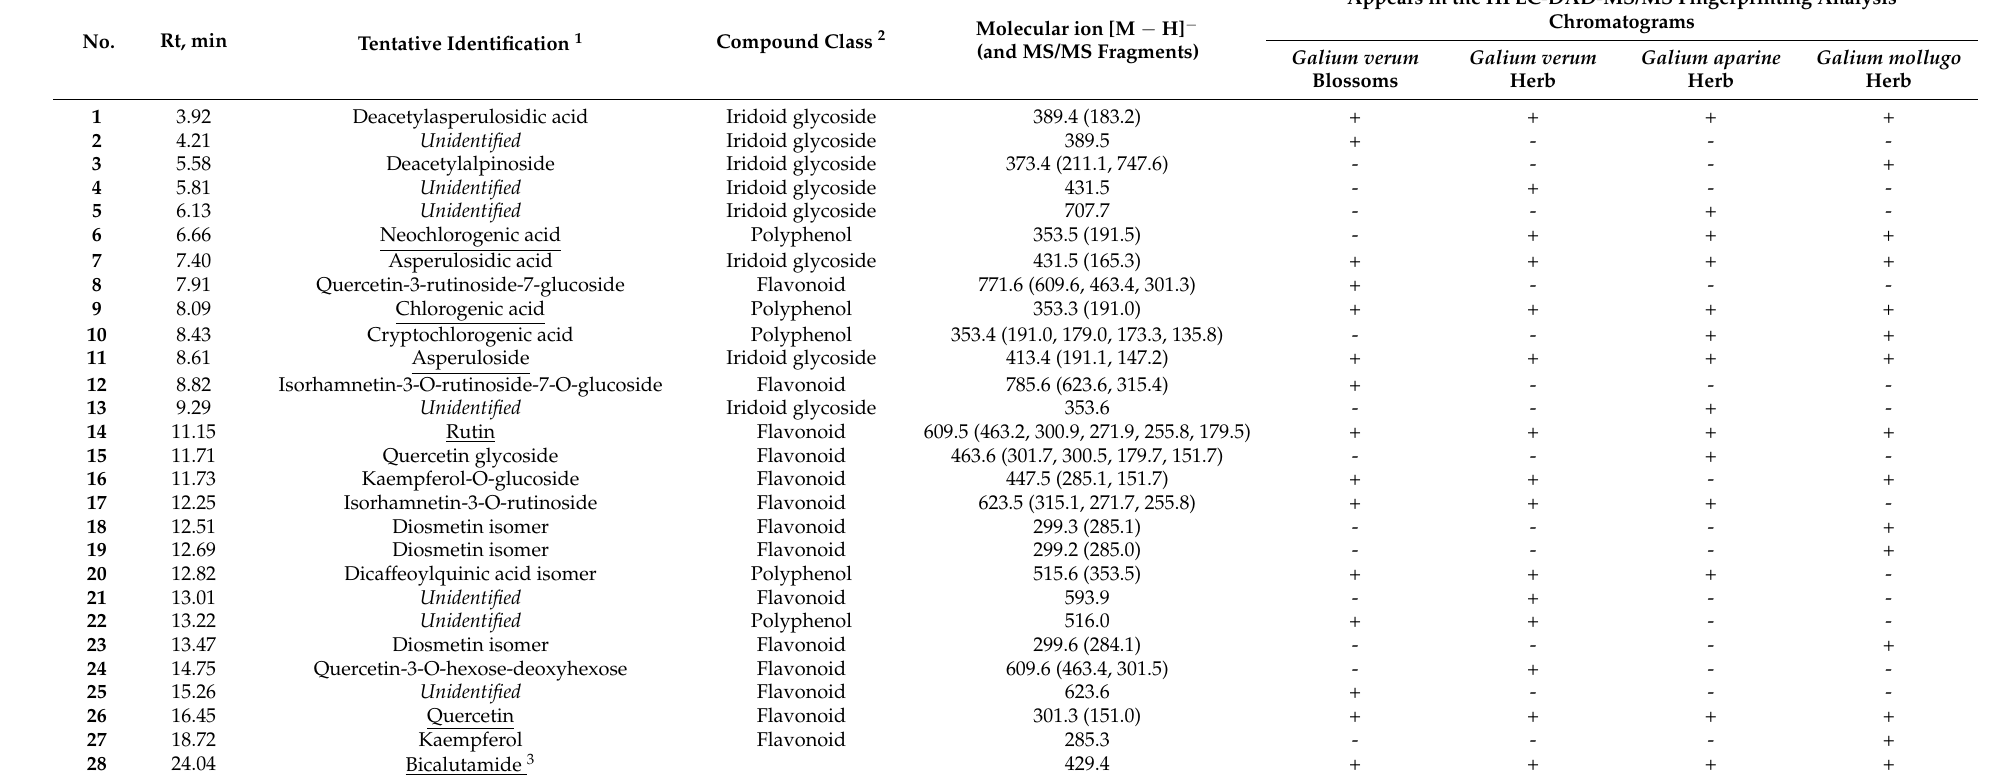
Table 2. Identification of all quantified compounds in the Galium